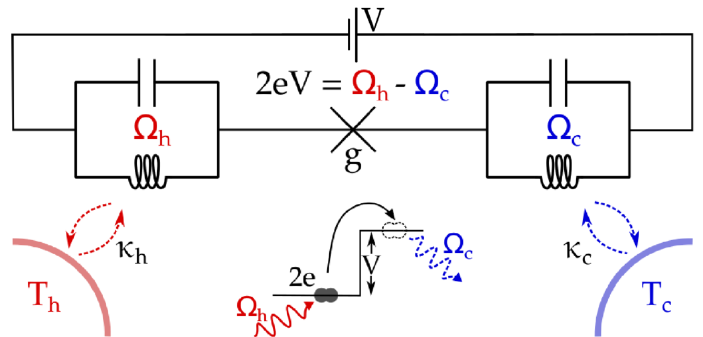
Figure 1: Quantum heat engine based on a voltage biased superconducting circuit. Two single-mode microwave resonators (LC-circuits) with frequencies Ω coupled via a Josephson junction, with an effective coupling strength g . Each res- ≥ T kept at temperatures T . While the inset explains the average behavior of h c